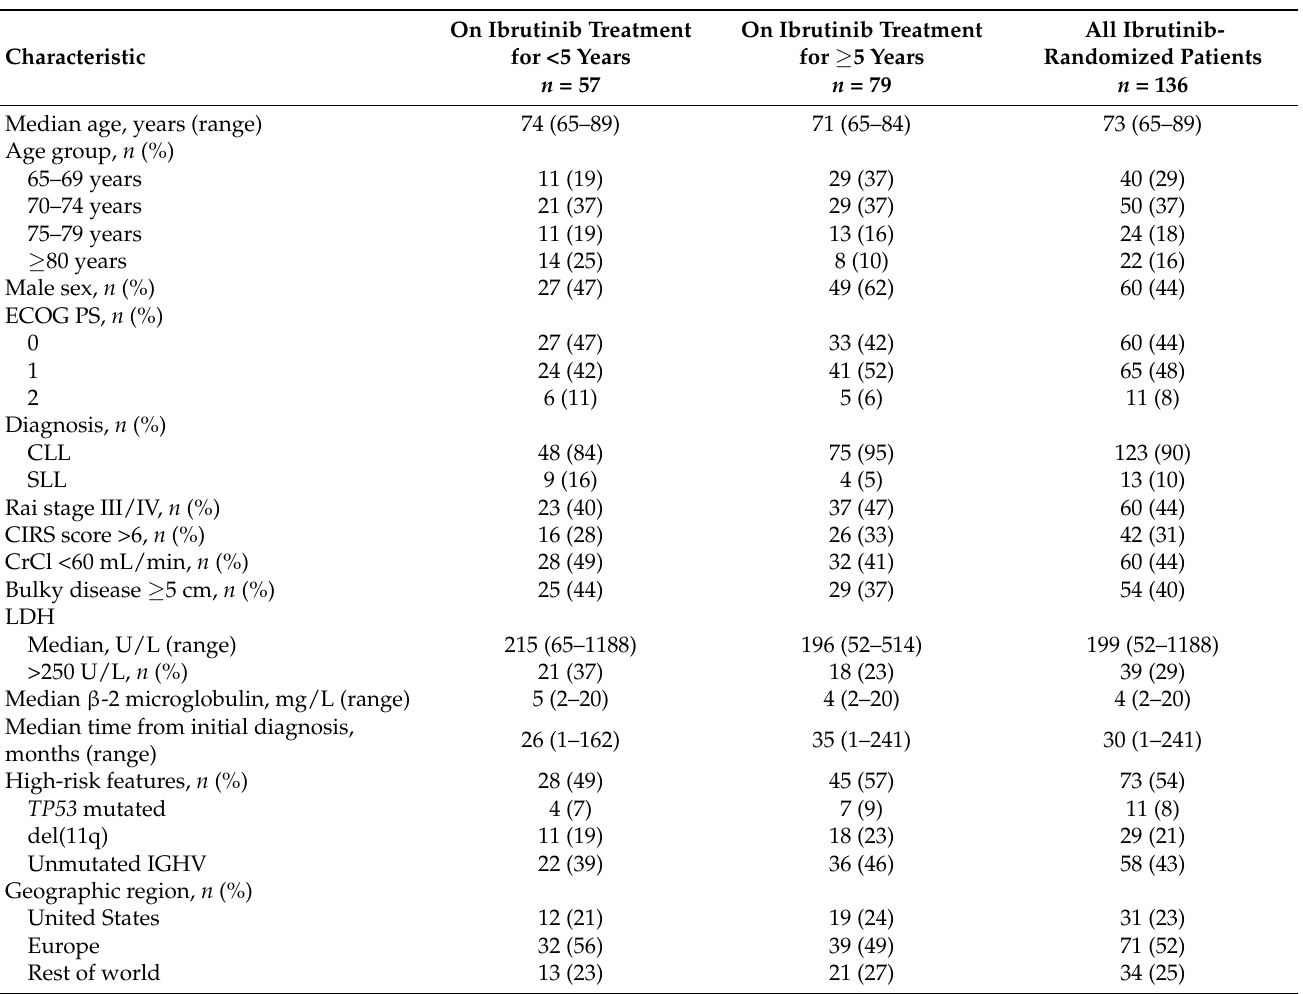
Table 1. Baseline